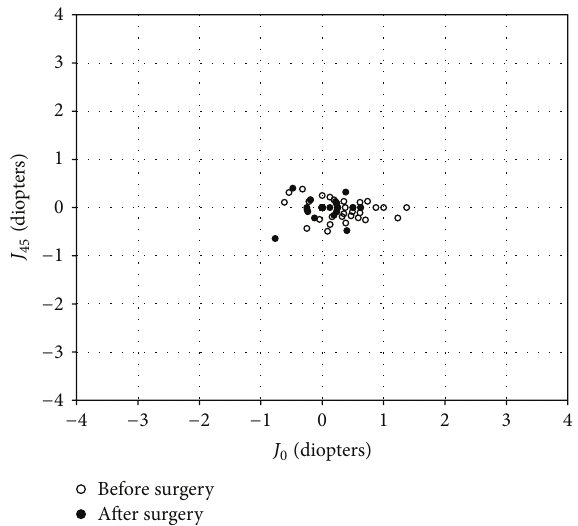
Figure 3: Power vector analysis of refractive astigmatism before and after refractive lenticule extraction (ReLEx), plotted as an astigmatic vector for each eye, referenced to the spectacle